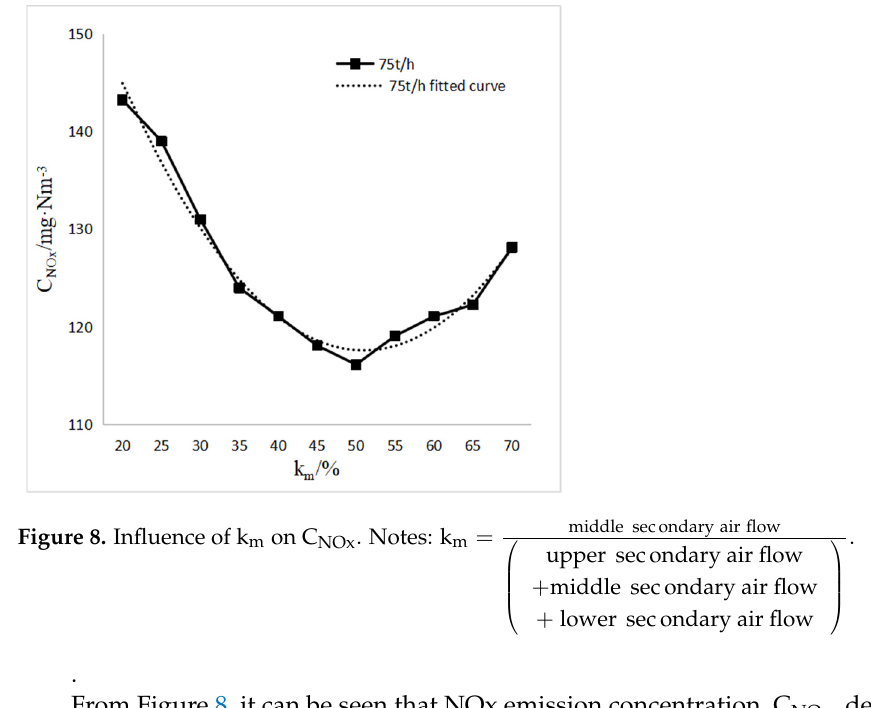
upper secondary air flow middle secondary air flow